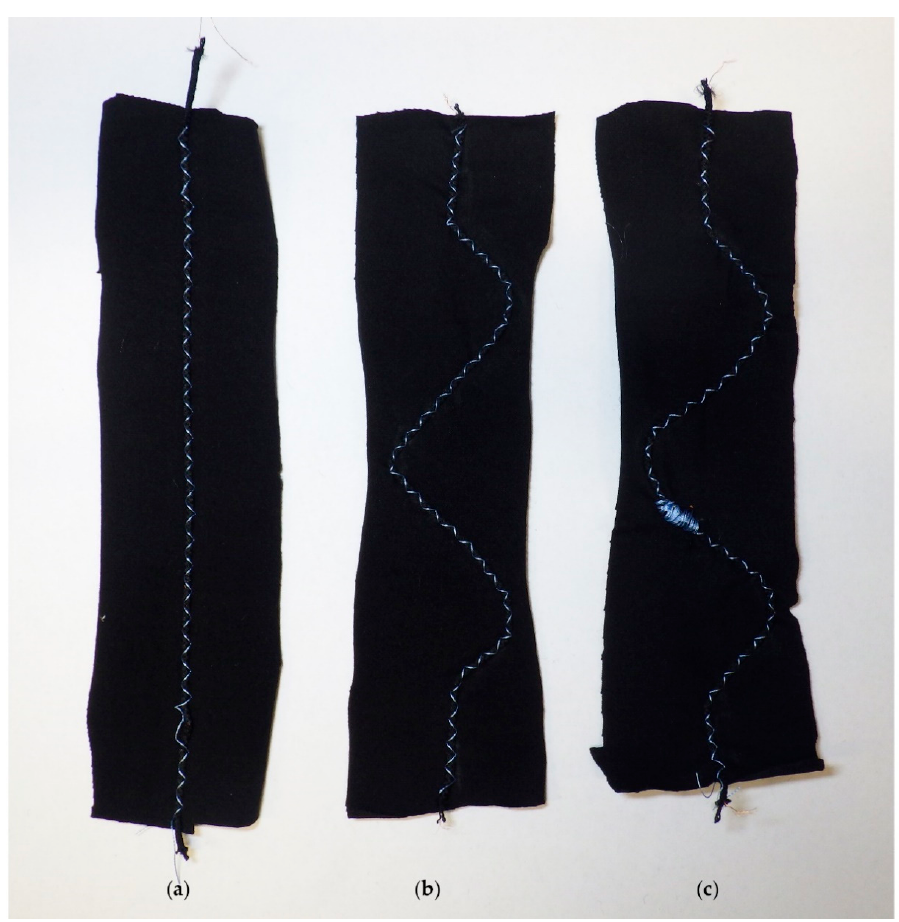
Figure 7. Samples of stretch fabric with attached E-yarns as prepared for tensile testing. From left: ( a ) Straight E-yarn; ( b ) Curved E-yarn; ( c ) Two curved E-yarns with a connection covered by a satin stitch.